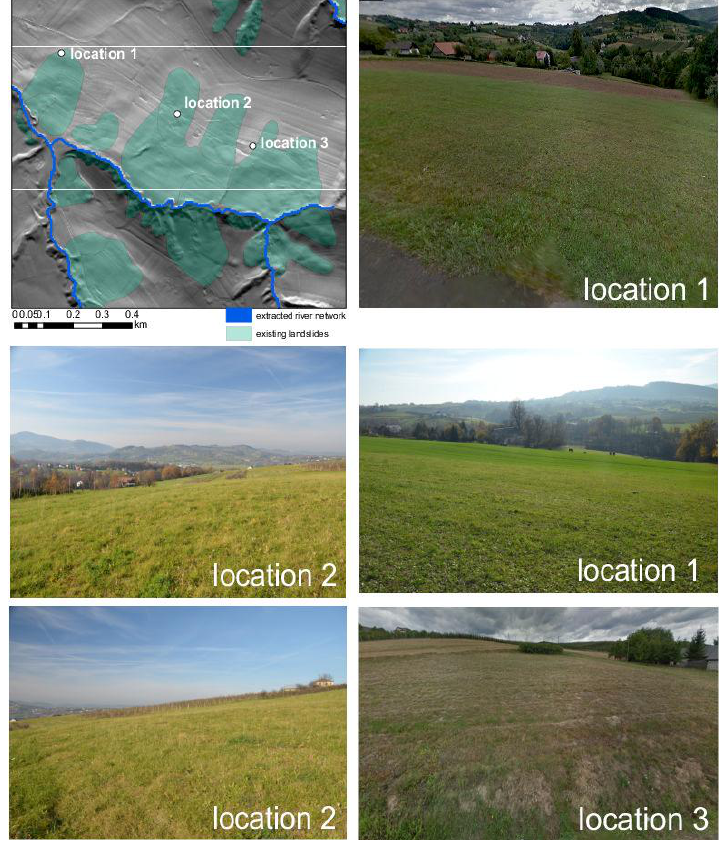
Figure 11. Challenges of automatic landslide detection in agricultural areas.